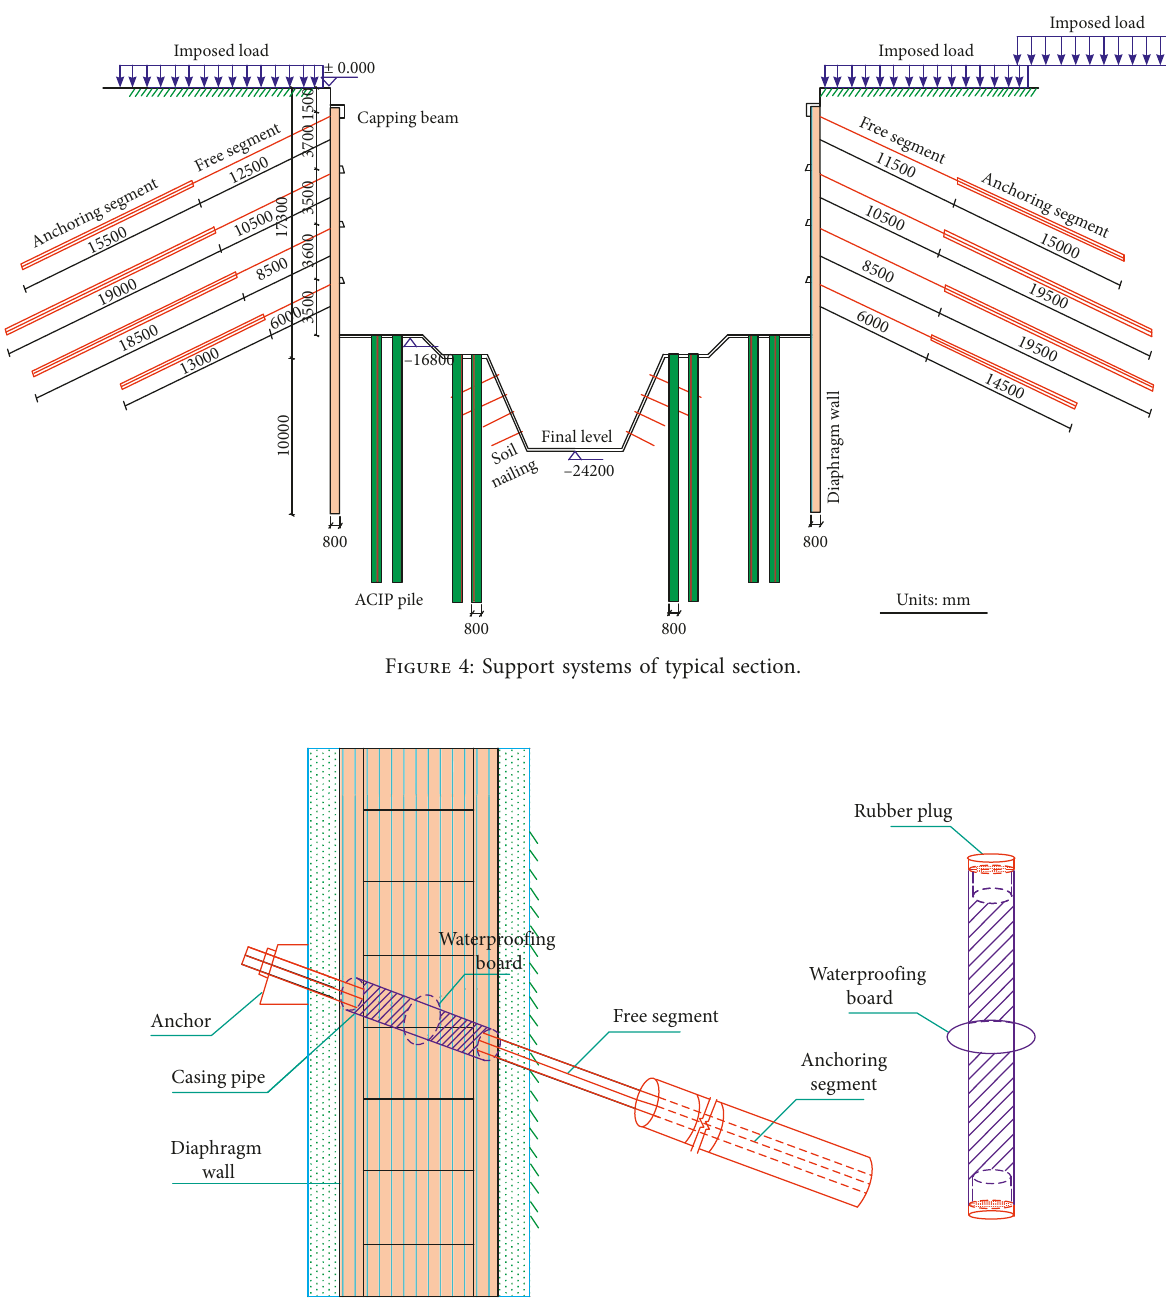
Figure 5: Connection node between the diaphragm wall and cable.